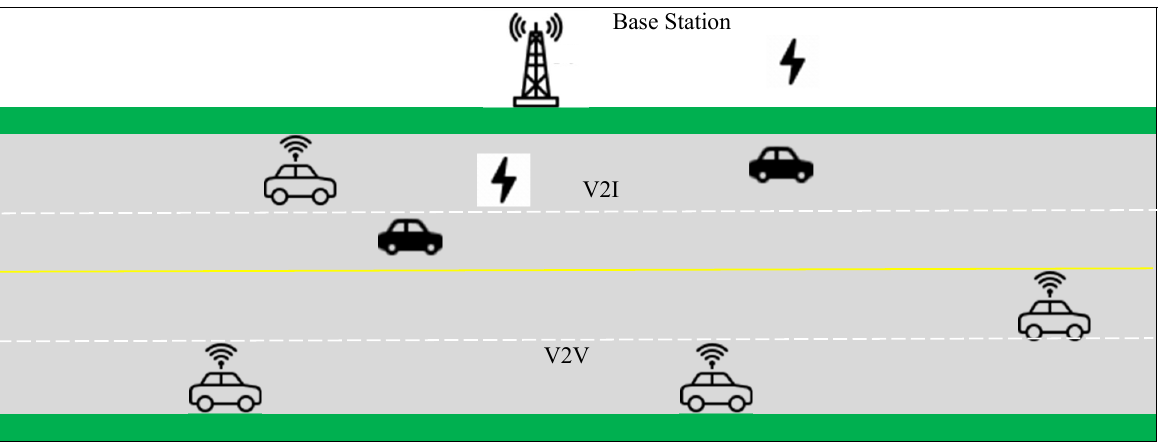
Fig. 1. Vehicle Communications VEHICLE (Liang, Peng, Li, & Shen,